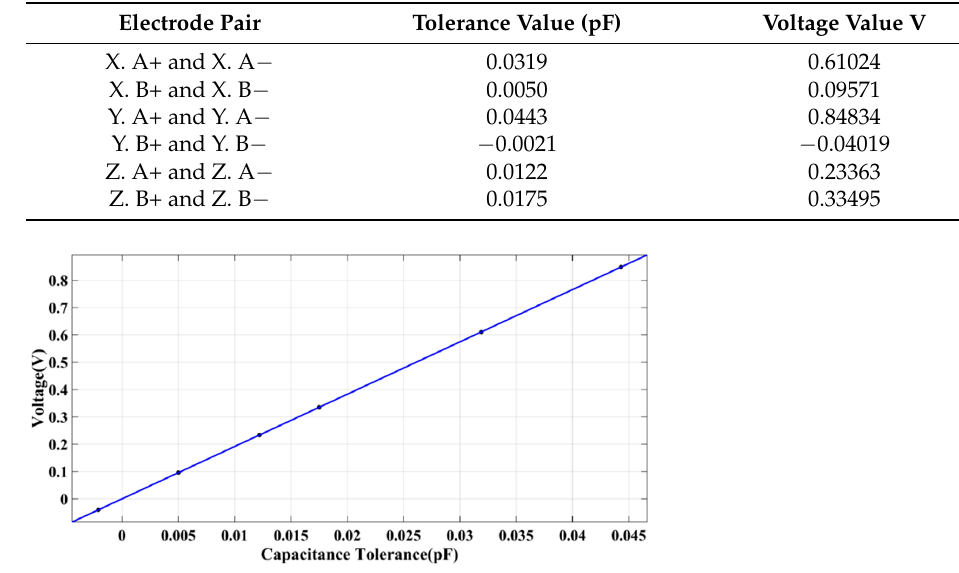
Figure 12. Fitted circuit gain curve for the capacitive sensing system.